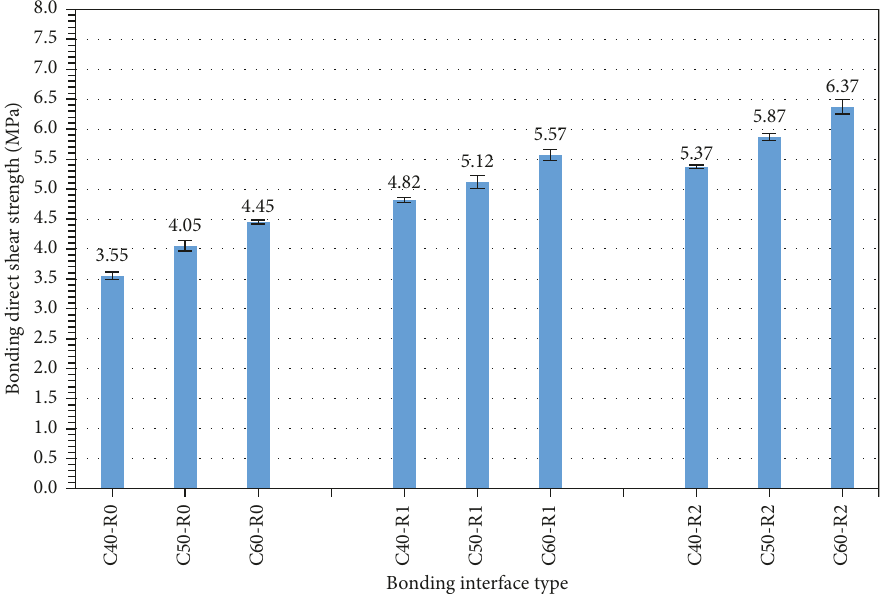
Figure 28: Bond direct shear strength under different interface roughness and cement concrete of different strength